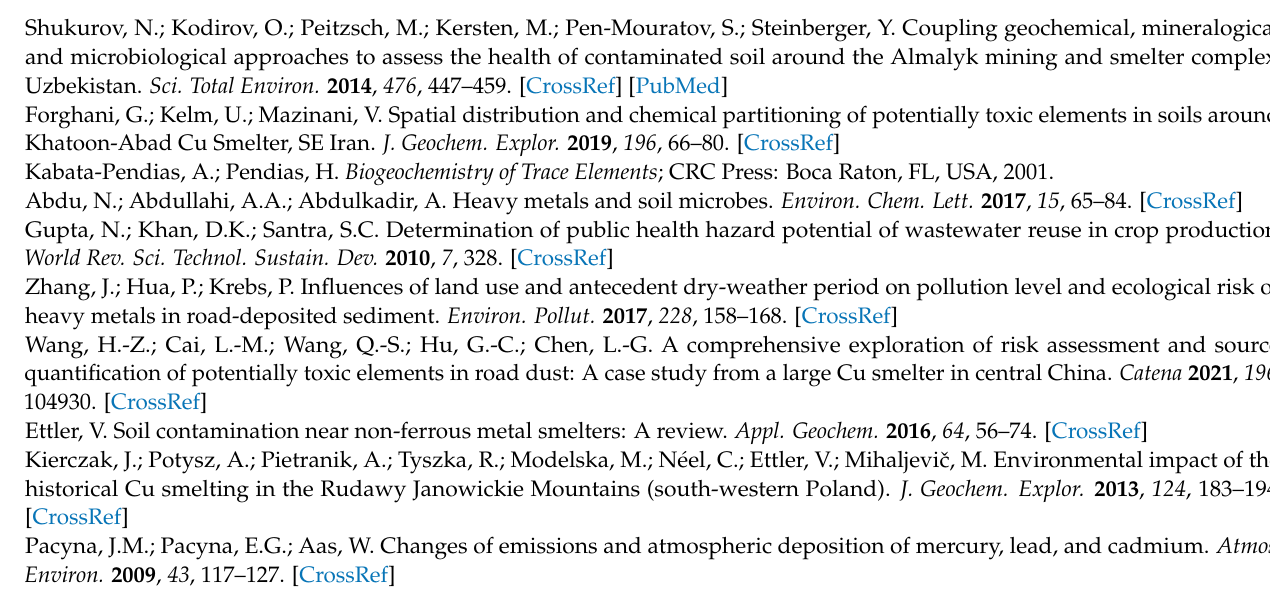
Table S2. The value for parameters for calculation of exposure dose. Table S3. The values of the reference doses (RfD). Table S4. Results of one-way ANOVA for studied sites within smelters. Table S5. The permissible concentrations of potentially toxic elements in the soil. Table S6. Average Daily Dose (ADD) values for mercury, copper and arsenic—Legnica. Table S7. Hazard Quotient (HQ) and Hazard Index values for mercury, copper and arsenic—Legnica. Table S8. Average Daily Dose (ADD), Hazard Quotient (HQ) and Hazard Index(HI) values for mercury, copper and arsenic—Glogow. Table S9. Average Daily Dose (ADD) for zinc, lead and cadmium—Oława. Table S10. Values of Hazard Quotient (HQ) and Hazard Index (HI) for zinc, lead and cadmium—Oława. Table S11. Average Daily Dose (ADD) values for zinc, copper, chromium, iron and lead—Siechnice. Table S12. Hazard Quotient (HQ) and Hazard Index (HI) for zinc, copper, chromium, iron and lead—Siechnice. Author Contributions: Conceptualization, M.W., A.T., and J.R.; data curation, M.W.; formal